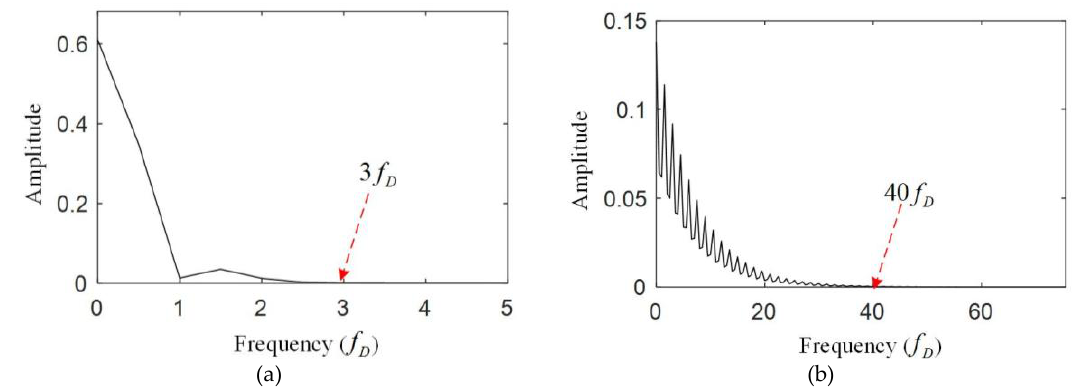
Figure 13. Frequency of the light spectra of ( a ) the FBG and ( b ) the comb filter during the upslope of the triangular wave.